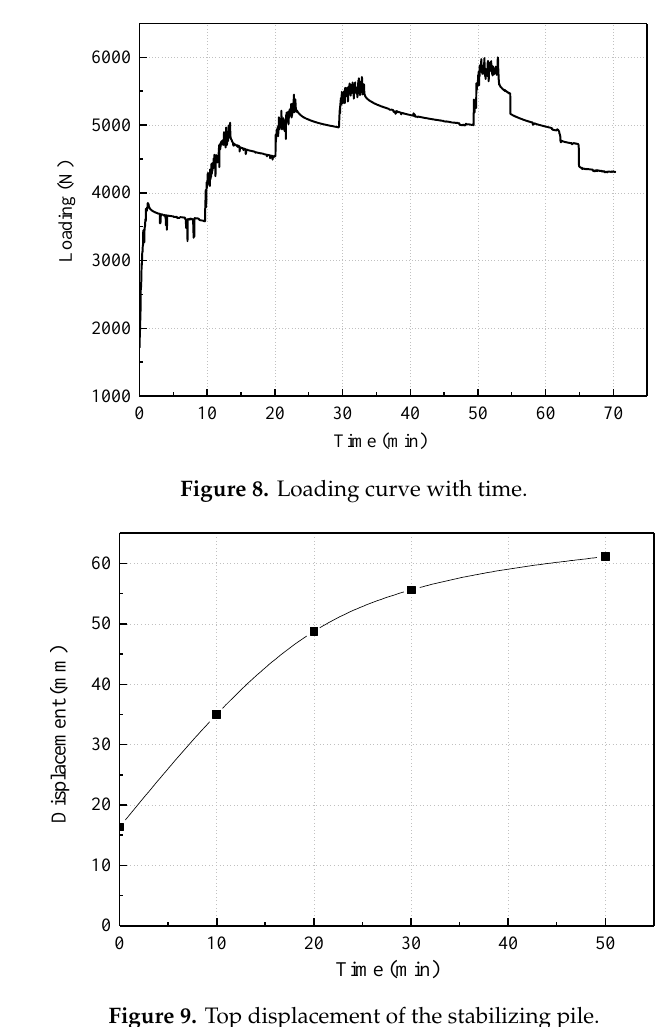
Figure 9. Top displacement of the stabilizing pile.